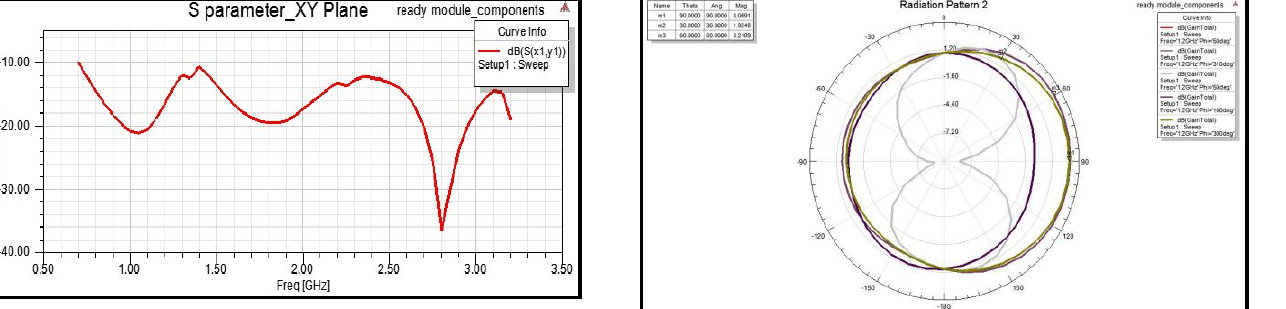
Figure 8: Polar Radiation Pattern of Antenna at